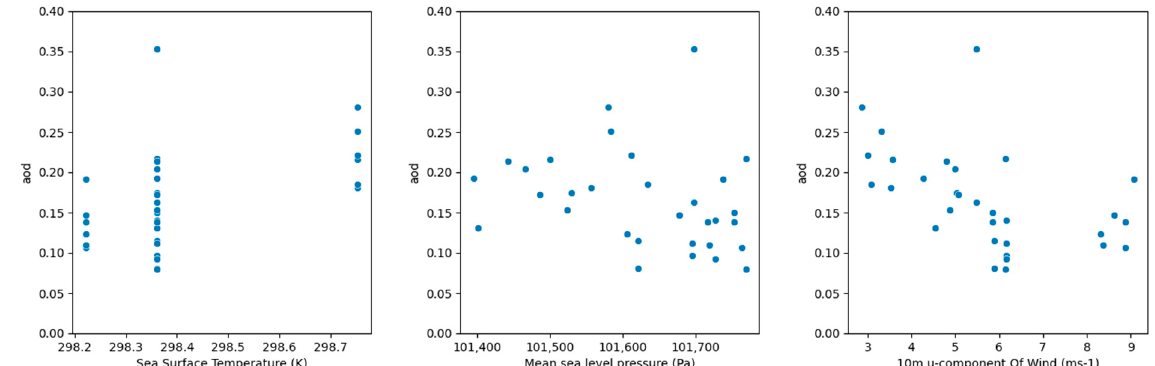
Figure 12. AOD-meteorological relation in winter.